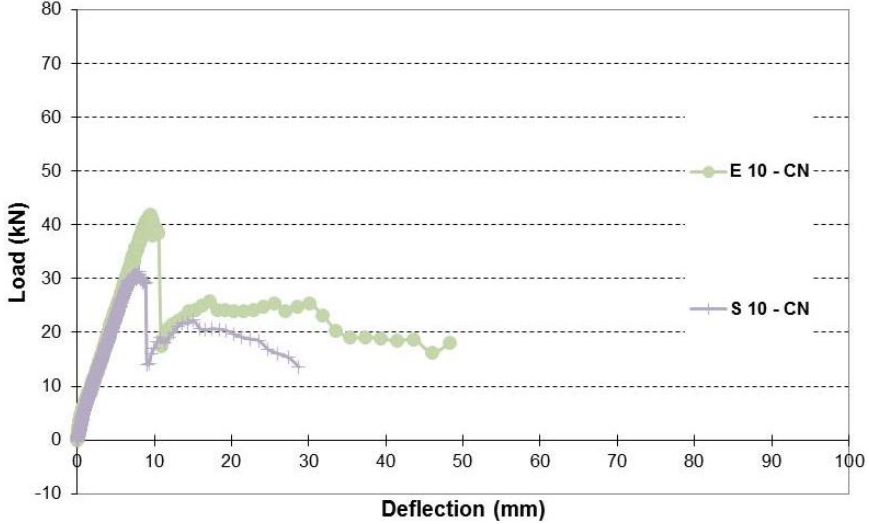
Figure 14. Load-deflection of beams with 10% corrosion levels (No repair).